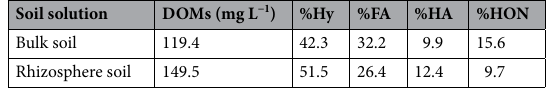
Table 2. Subfractions of DOM in the soil solution.